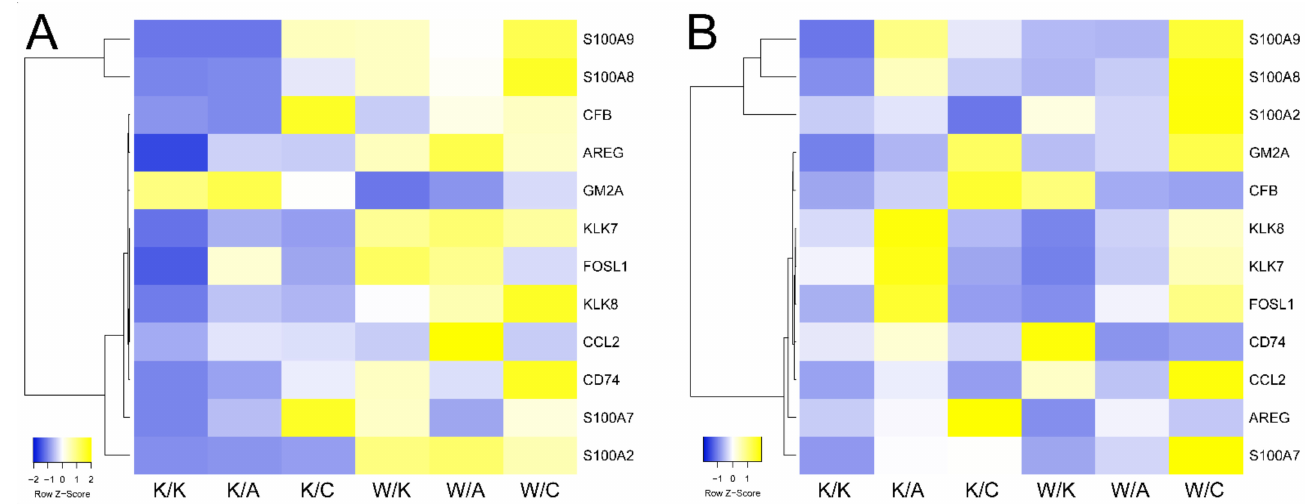
Figure 11. Expression of the most frequent and interacting DEGs across cellular variants. ( A ) HT-1376 variants. ( B ) CAL- 29